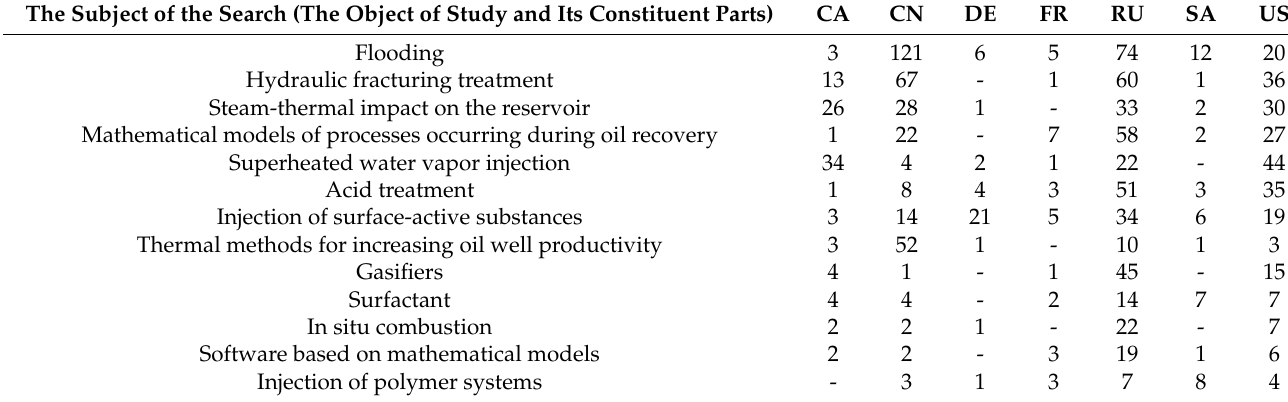
Table 2. Technological clustering in the direction of enhanced oil recovery methods in 2010–2020 split between key countries for a highly competitive